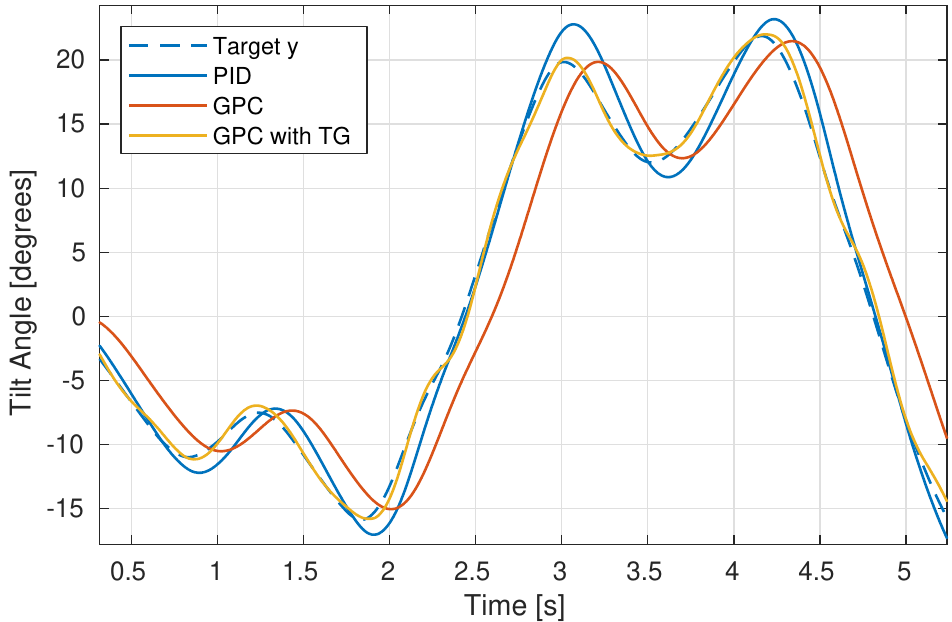
Figure 4. The Fixed Trajectory Experiment: complete target trajectory and the highlighted part of the experiment.